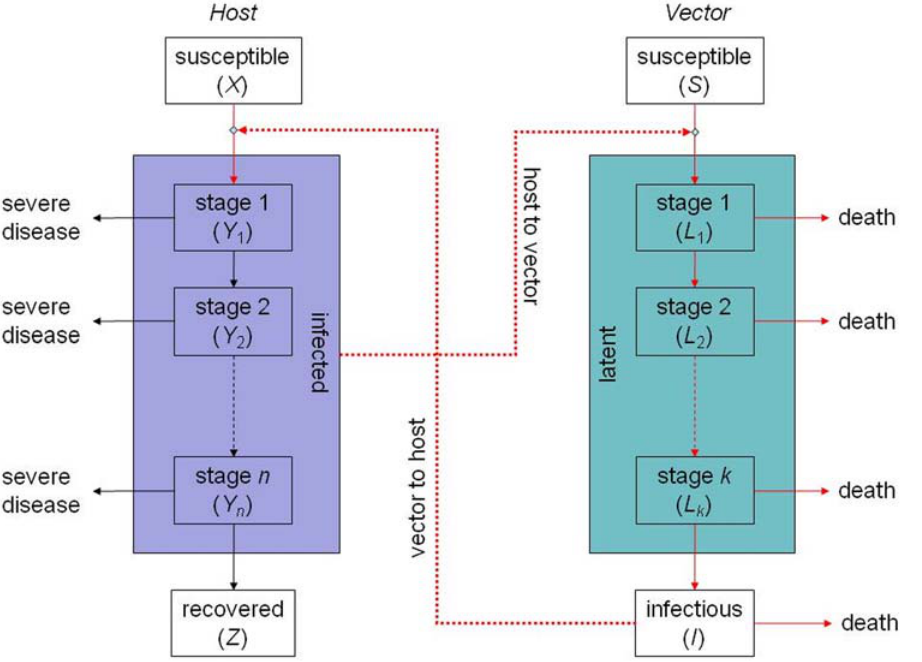
Figure 1. Schematic diagram of the model for the transmission dynamics of BTV within a farm. The populations of infected hosts and vectors are subdivided into a number of stages to allow for more general distributions for the duration of viraemia and the extrinsic incubation period, respectively. A solid line indicates a flow from one compartment to another; a dotted line indicates that a compartment has an influence on a rate of transfer. Lines shown in red indicate a temperature-dependent rate.